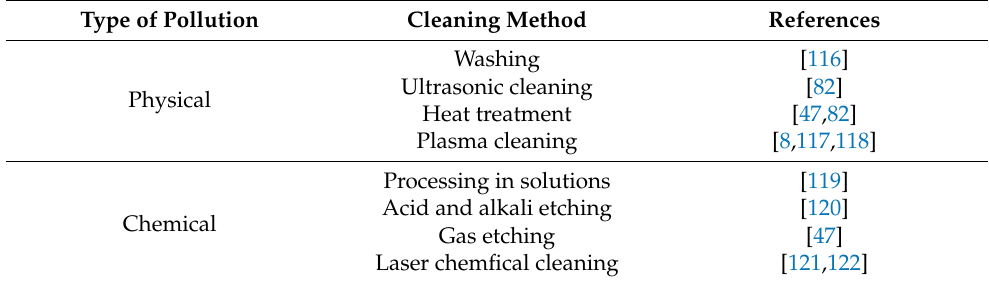
Table 4. Pollution classification.